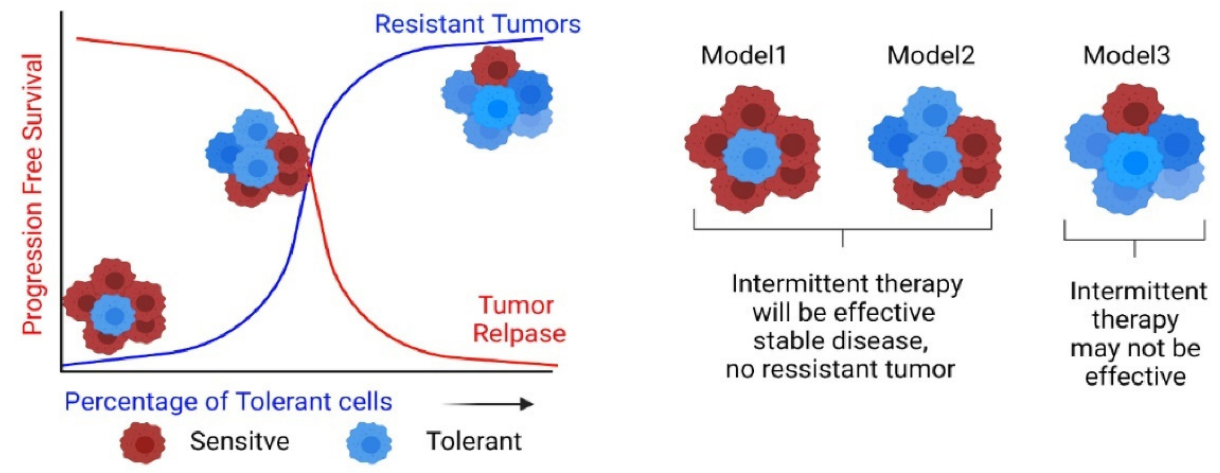
Figure 4. The cartoon representing the importance of tumor heterogeneity on therapeutic approach, continuous verses intermittent.